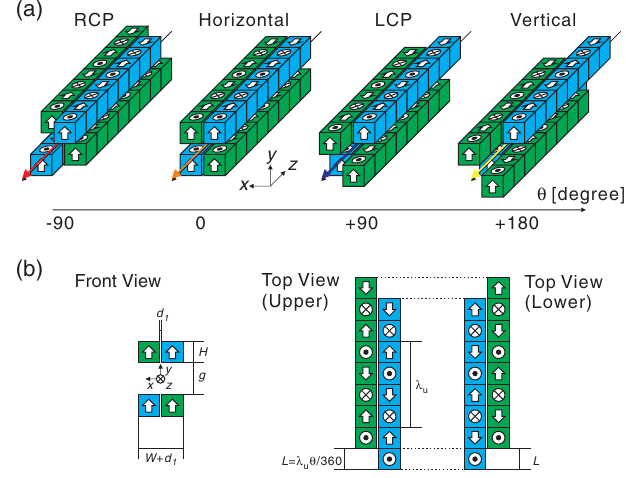
FIG. 1. Outline of the APPLE undulator: (a) magnet configu- rations to generate four typical polarization states, and (b) geom- etry to calculate the magnetic force.